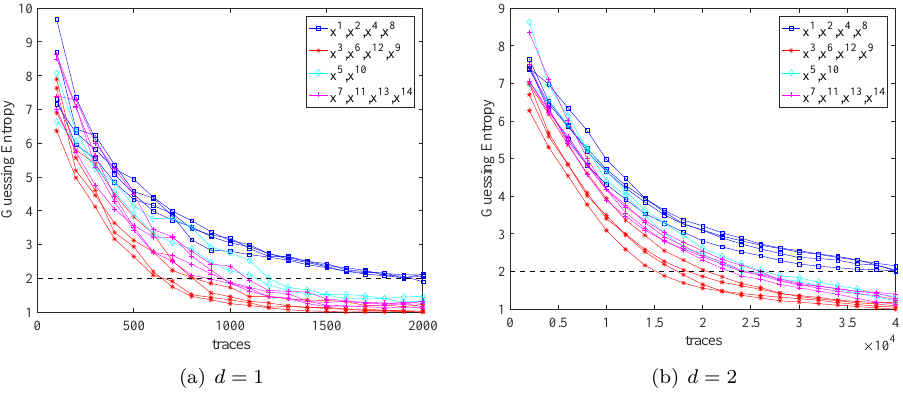
Figure 16: The results of GE for n = 4 and σ = 2.